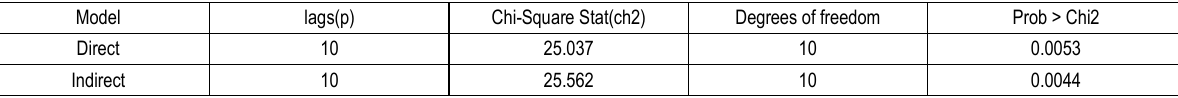
Table A2. Results of the Breusch-Godfrey test for serial